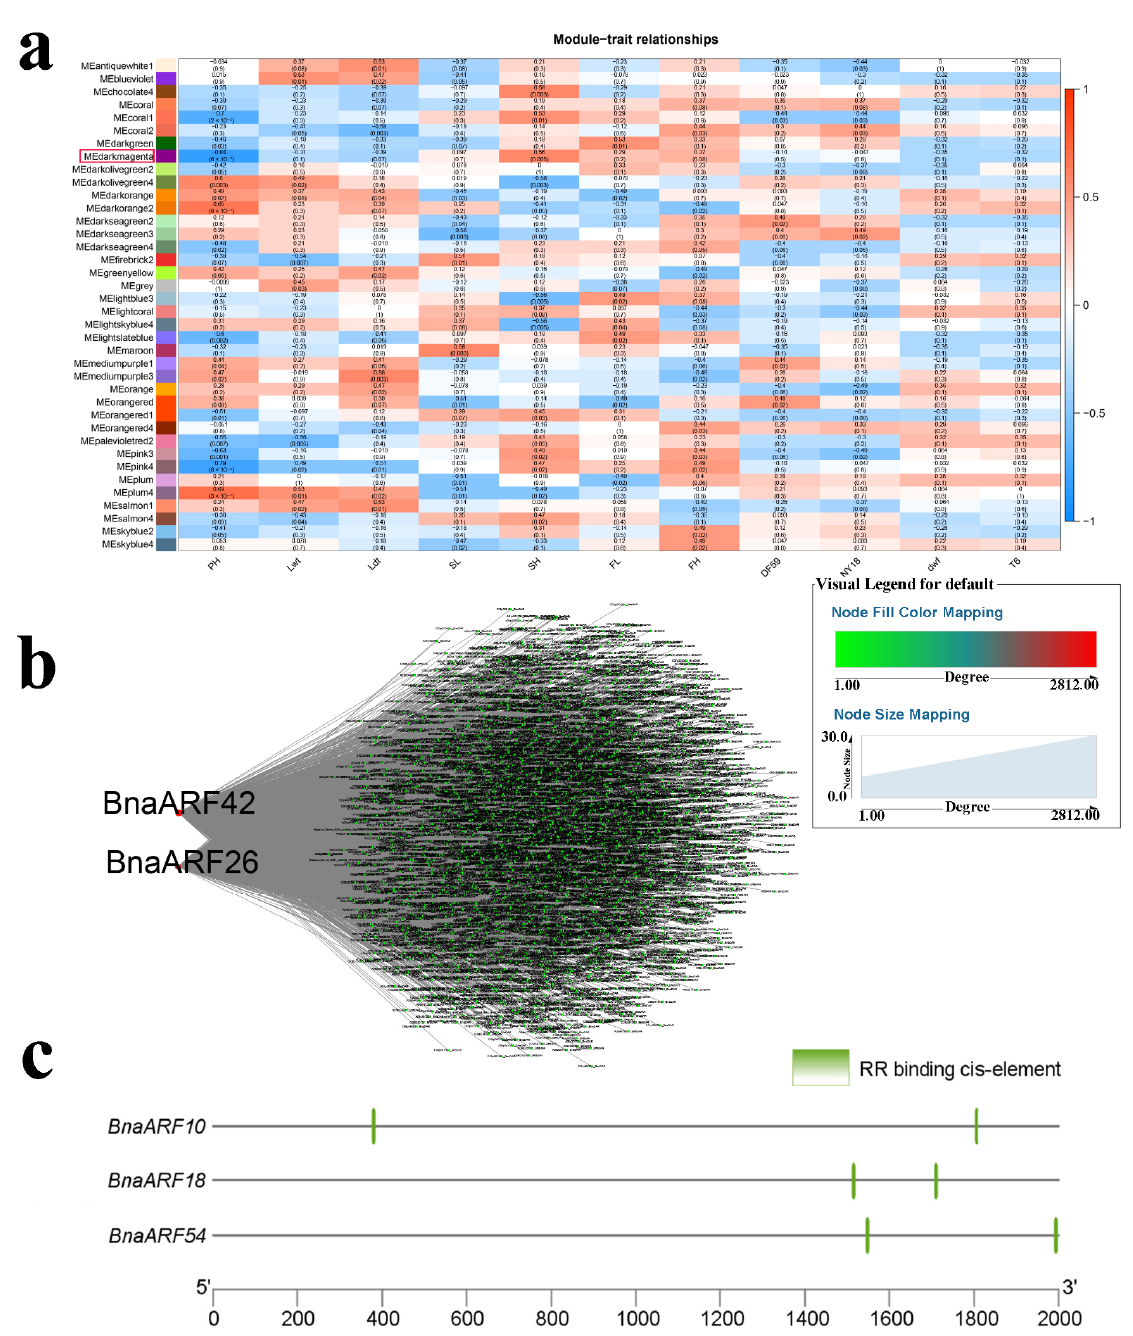
Figure 8. WGCNA of rapeseed genes identified in dwarf mutants. ( a ) Module-trait correlation showing the significance of module eigengene correlation with traits (PH). Left panel shows modules. ( b ) Cytoscape representation of the relationship of hormone-related TFs in “darkmagenta” module. Key genes are represented by large red circles. ( c ) RR-binding cis -element in the promoter of BnaARFs